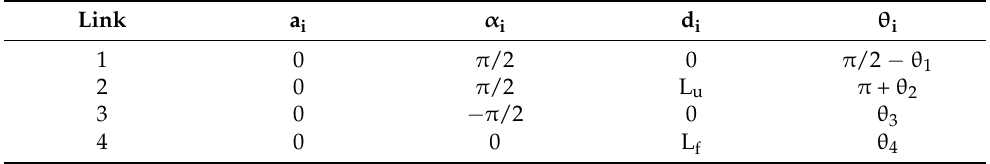
Table 2. Denavit–Hartenberg parameters of the EXOTIC exoskeleton. Parameters L u and L f corre- spond to the lengths of the upper arm and forearm, respectively, which are both